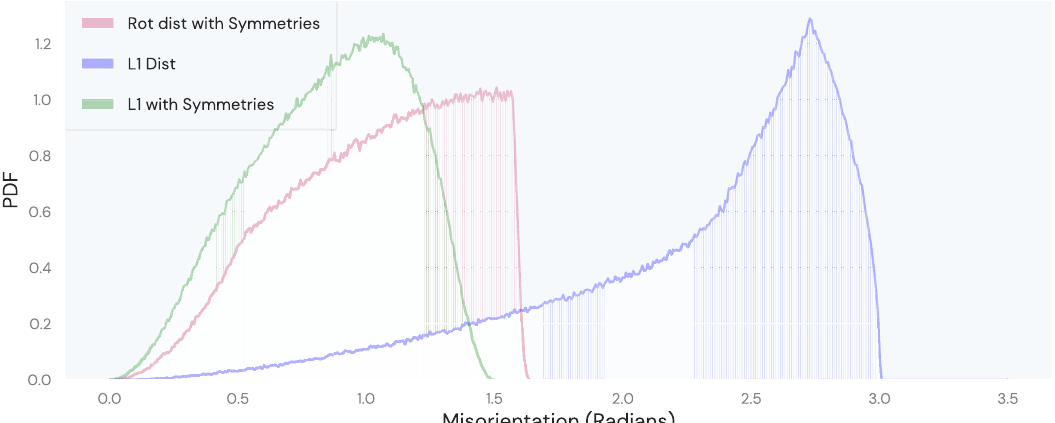
Fig. 2 Orientation loss distributions. Probability distribution of loss distances between pairs of randomly sampled 3D rotation vectors. L 1 distance is shown in blue, L 1 distance accounting for crystal symmetry is shown in green, and approximate rotational distance accounting for crystal symmetry is shown in